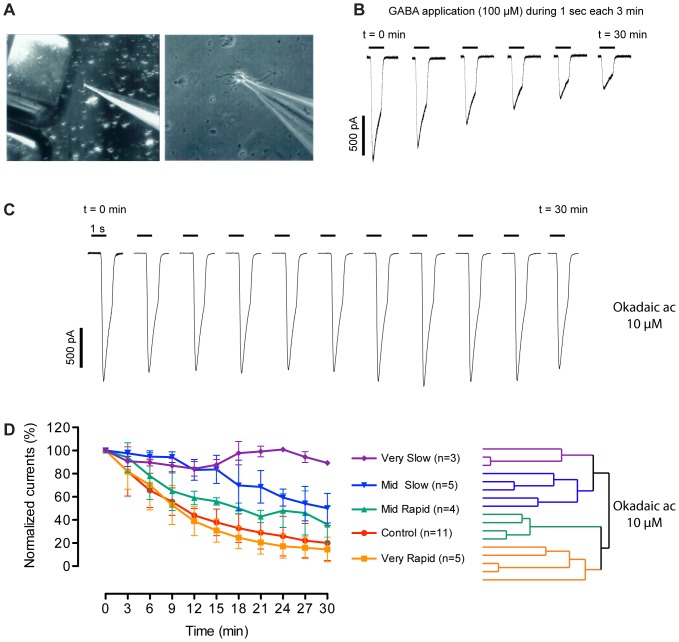
Effects of okadaic acid on the GABAA current rundown.GABAA currents were measured by whole-cell patch clamp on acutely dissociated cortical pyramidal neurons from Sprague Dawley rats. (A) Micrographs of a patched cell at two different magnifications, showing the rapid application device (left). (B) Rundown in cortical neuron: GABA was applied at a concentration of 100 µM during 1 second every 3 min. The maximal amplitude of GABAergic currents gradually decreased with time in control conditions. In presence of okadaic acid (10 µM in the pipette) variable effects were observed. (C) In some cells the rundown was even totally abolished. (D Left) Rundown profiles of normalized currents in presence (n = 17) or in absence (Control, n = 11) of okadaic acid; (D Right) color-coded hierarchical clustering tree for the recorded okadaic acid-treated cells in which a maximum of 4 groups are significantly distinguished: ‘Very Slow’ (n = 3), ‘Mid Slow’ (n = 5), ‘Mid Rapid’ (n = 4) and ‘Very Rapid’ (n = 5). For each group the plot (Left) is the average of normalized currents. Error bars indicate the SEM. One-way ANOVA with Dunnett’s test of mean currents and Student t-test were used (see in Results) indicating very likely that more than one phosphatase are involved.